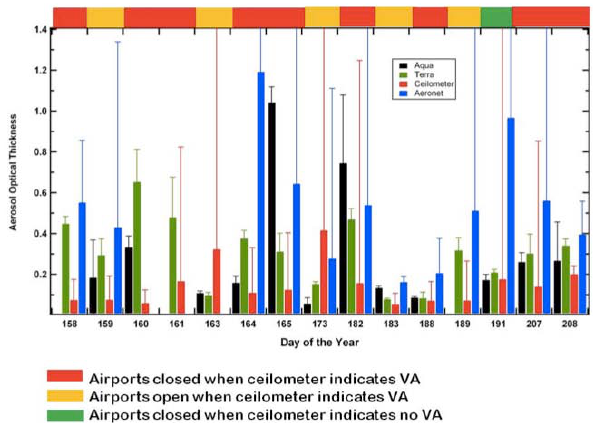
Fig. 8. The aerosol optical thickness (AOT) is shown here from the MODIS instrument on the Aqua (black) and Terra (green) satellites and derived from the ceilometer (red) and AERONET (blue). The ceilometer and AERONET AOT are averages made over the time periods of Aqua and Terra overpasses. The vertical bars represent the uncertainties, derived for the satellite measurements from the number of pixels from which the AOT was derived, and the com- puted standard deviations from the averaged values of ceilometer and AERONET. The days shown are taken from Table 1 and the color-coding indicates how the ceilometer identified volcanic ash compared with the decision to close an airport. VA corresponds to volcanic